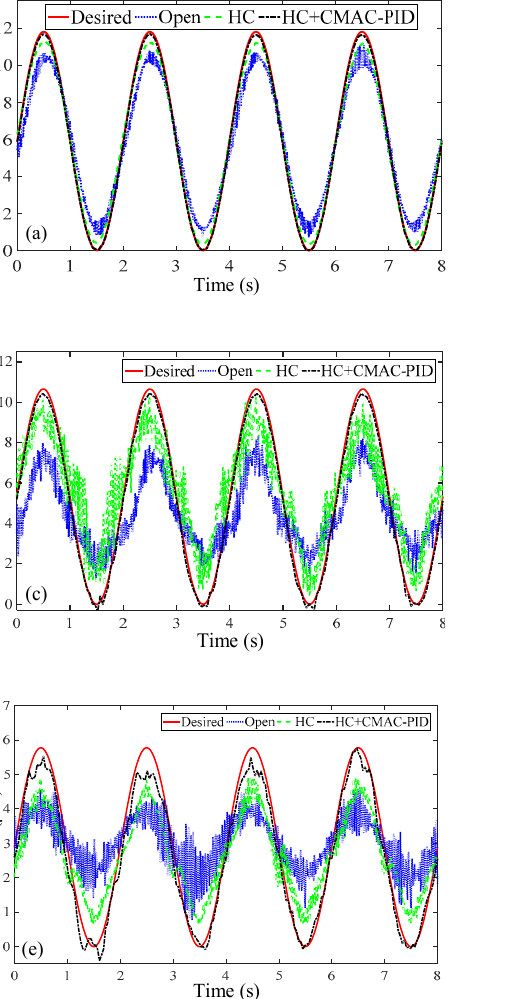
Figure 12. Experimental tracking results of ( a , b ) the translation along Z axis, ( c , d ) the rotation along X / Y axis, ( e , f ) the rotation along Z axis. Table 4. Experimental controller performance for the remaining degrees of freedom.